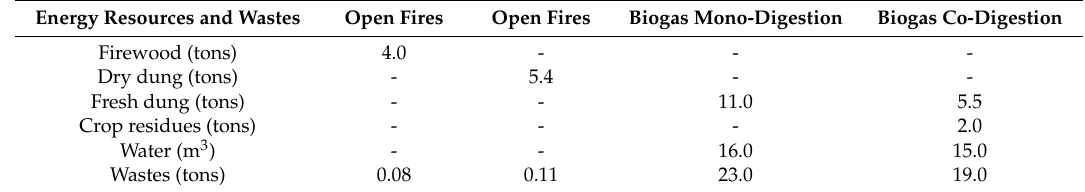
Table 1. The average amount of biomass required for the annual cooking energy demand and resulting waste in different